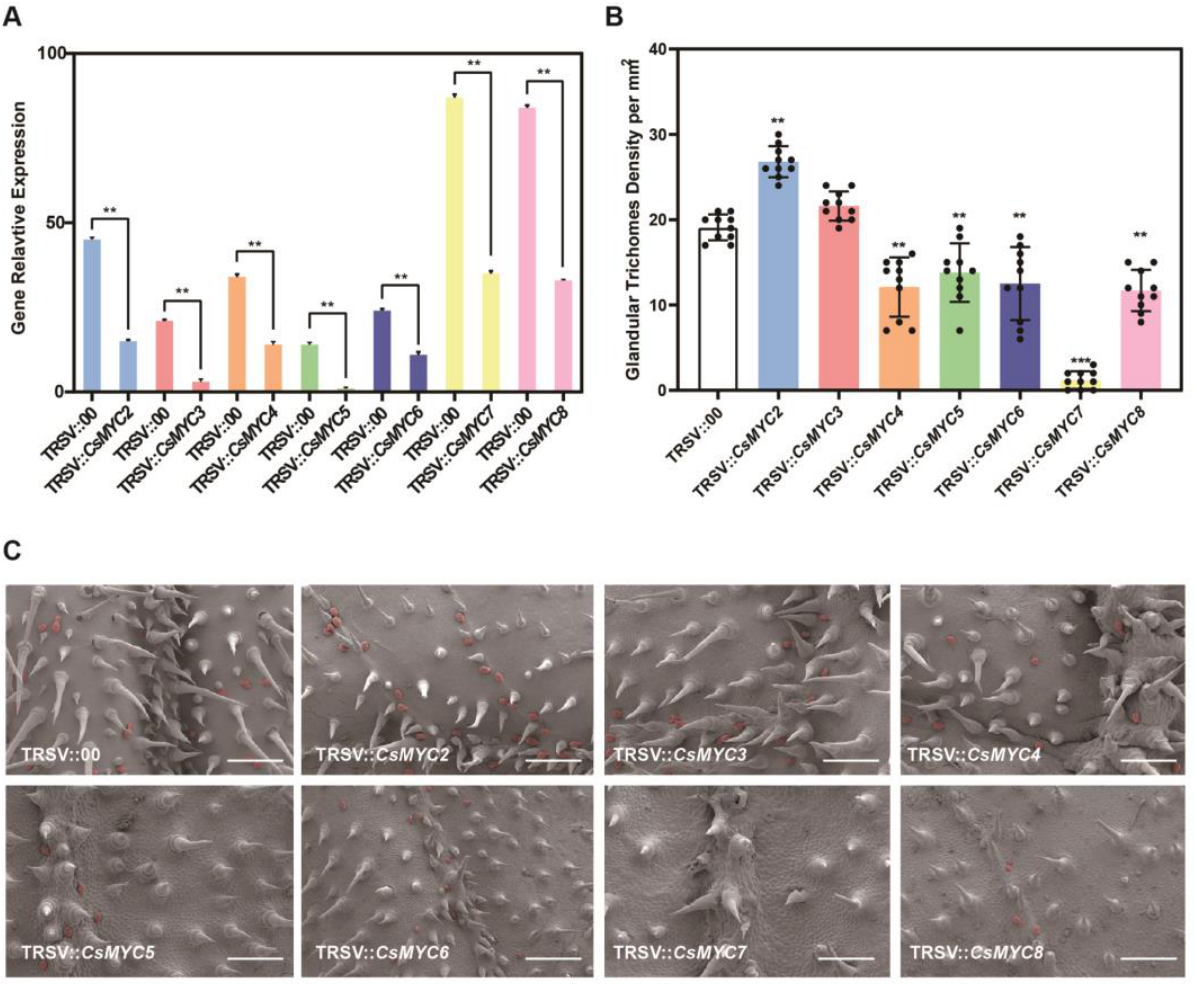
Figure 4. Gene function analysis of CsMYC2-CsMYC8 in cucumber glandular trichomes. ( A ) Gene expression levels in the respective VIGS silenced plants. CsTUA served as the internal control. ( B ) Density (per mm 2 ) of GTs in different VIGS silenced plants. Each scatter represents the mean of the density of each VIGS-positive plant. ( C ) Phenotypes of gene silenced plants on the first true leaf . The cucumber GT has been marked with a red color. Bars represent 500 μm. Error bars represent SD from three biological repeats. ** indicates p -value < 0.01. *** indicates p- value < 0.001.